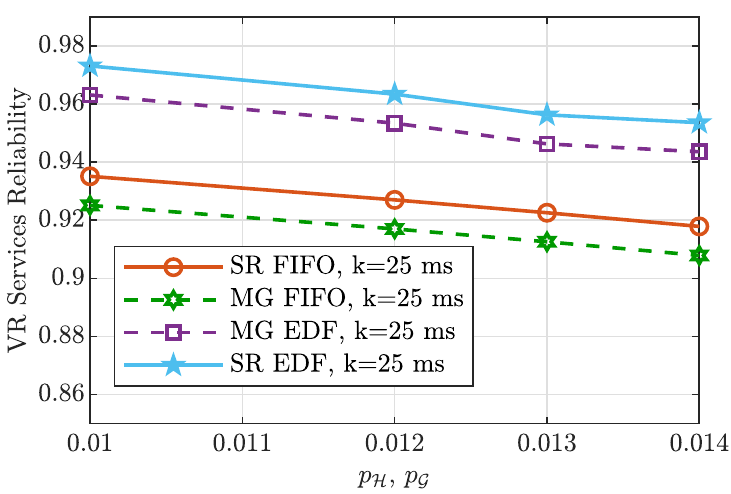
Figure 8. Reliability as a function of p c , p d , considering p H = 0.014, and p G = 0.01.